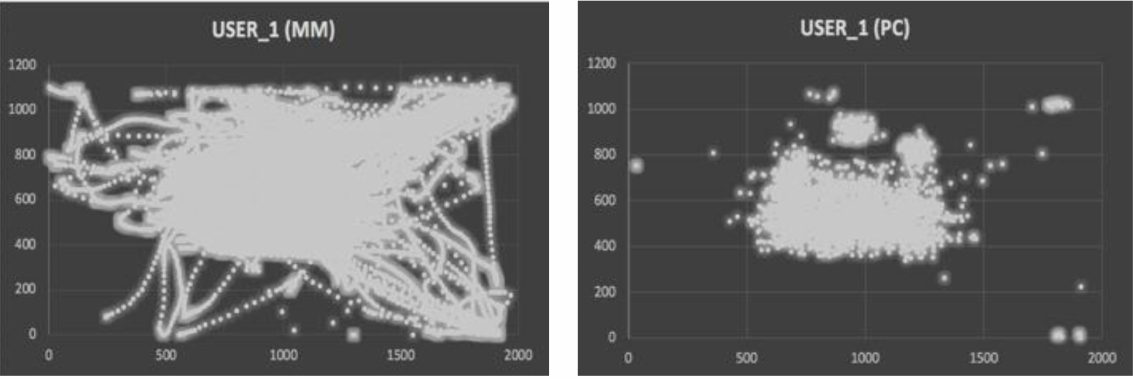
Figure 4. User 1 mouse movement, point-and-click actions.